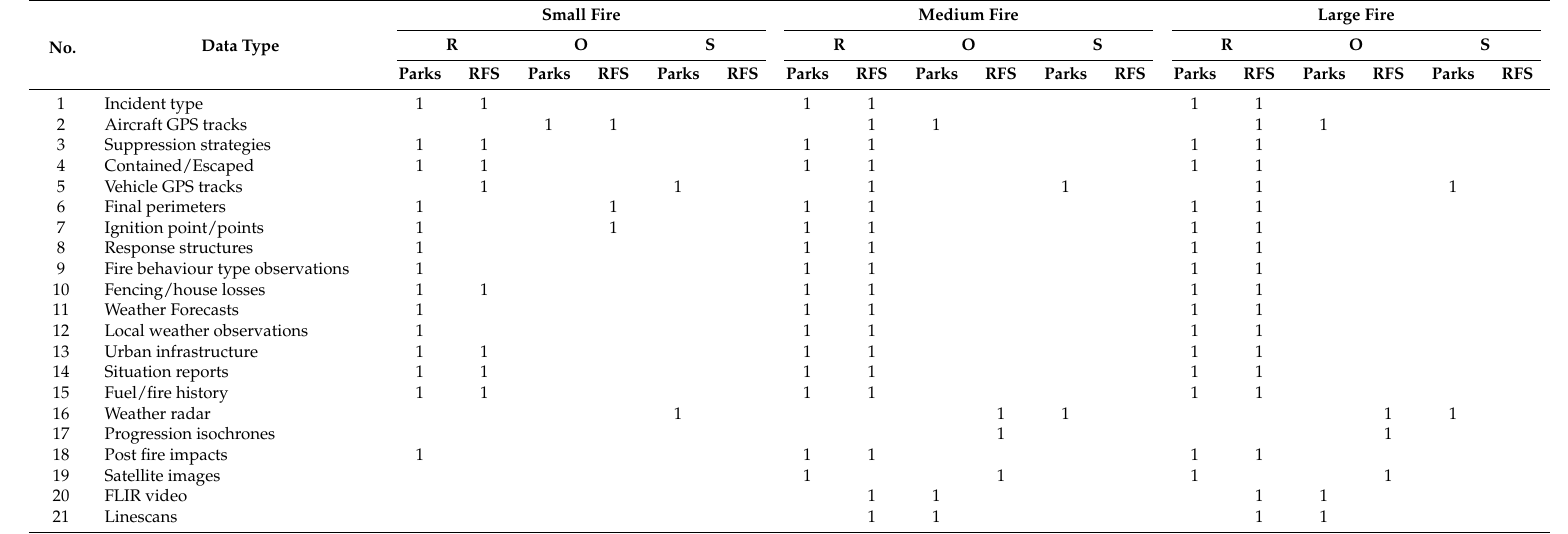
Table A3. Australian Capital Territory.